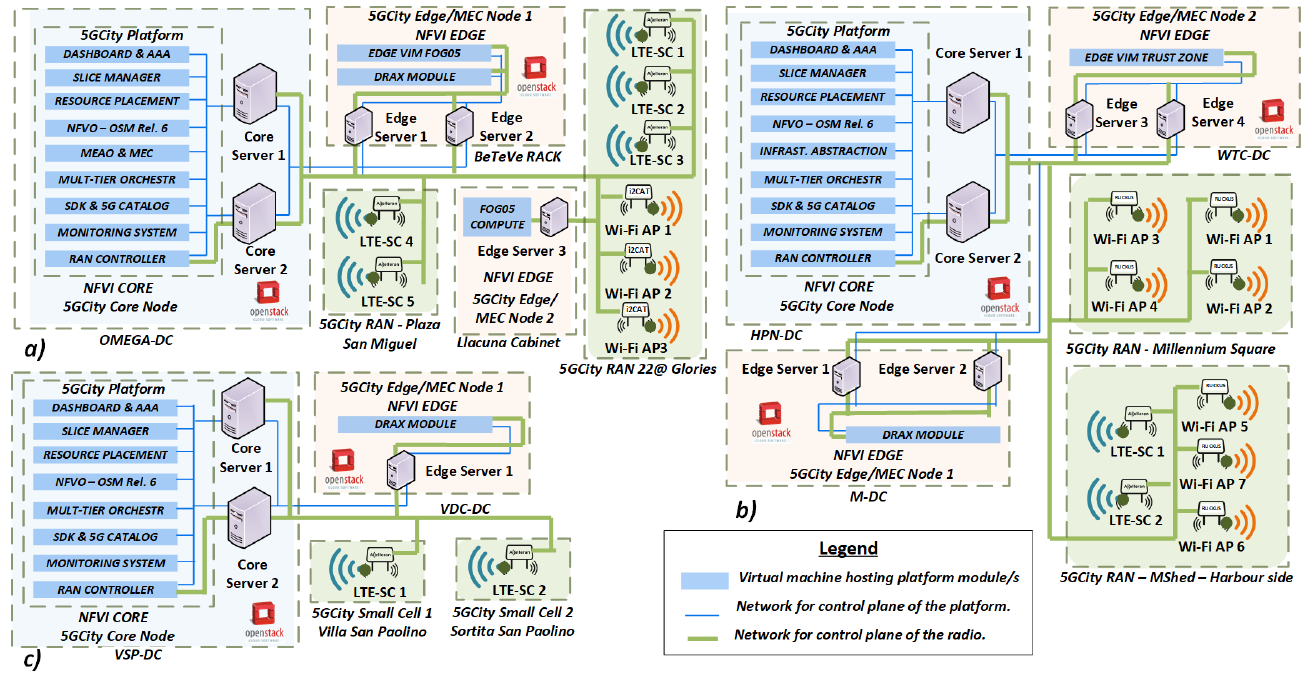
Figure 4. Platform deployed in ( a ) Barcelona, ( b ) Bristol and ( c )